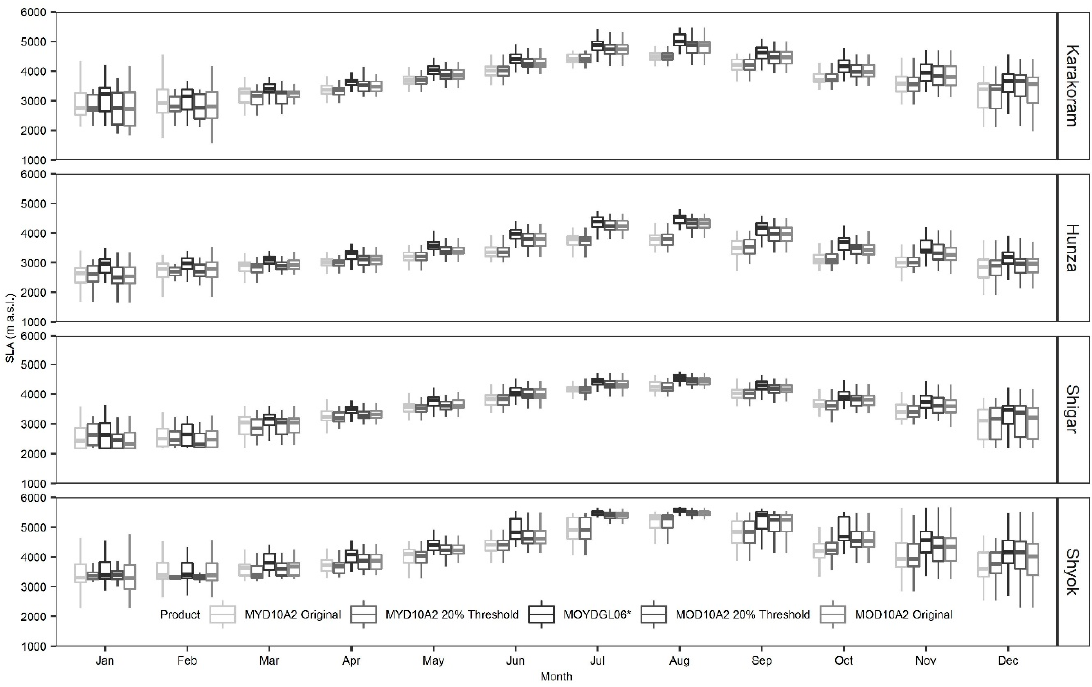
Figure 7. Boxplots illustrating the monthly SLA estimates derived from three different snow products. The median snowline value for each month is represented by the thick black solid line.